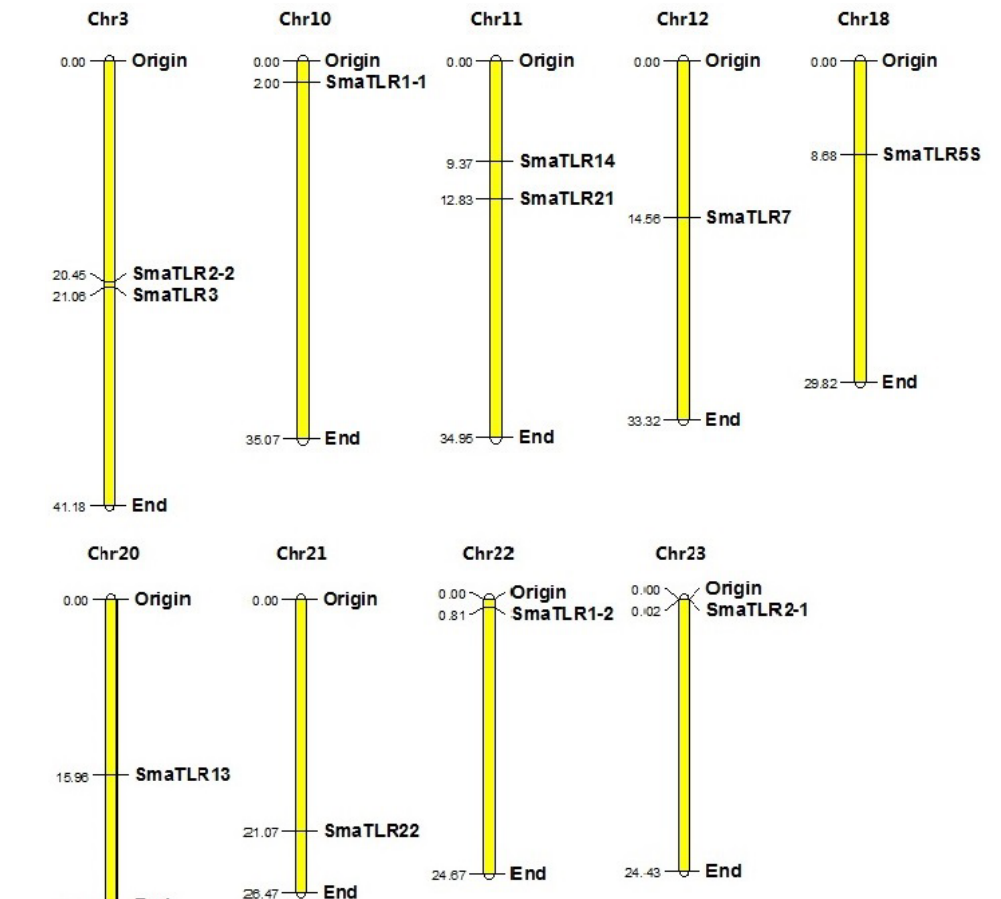
Figure 2. Chromosomal locations of the 11 TLRs in marbled rockfish. The origin and end represent the starting and ending positions of the chromosomes, respectively. The numbers in the figure represent the length of the chromosomes and the position of the genes. The unit is Mb.